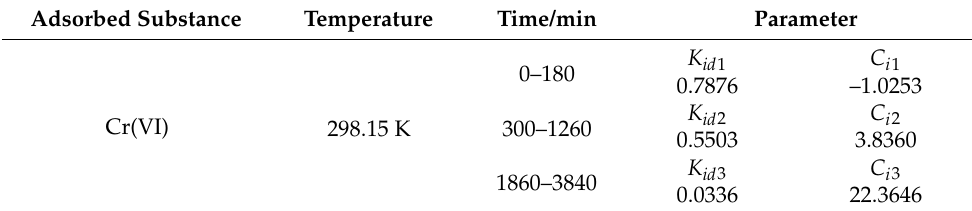
Table 2. Parameters of the Weber-Morris model.